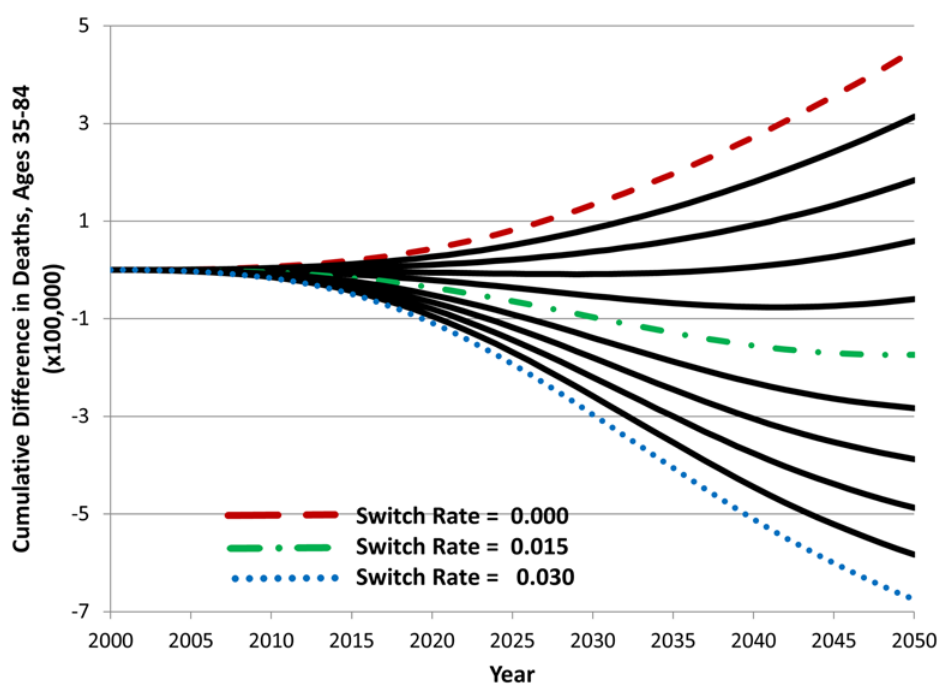
Fig 7. The effect of switching rate values on cumulative difference in deaths between the status quo and hypothetical scenario A, 2000 –